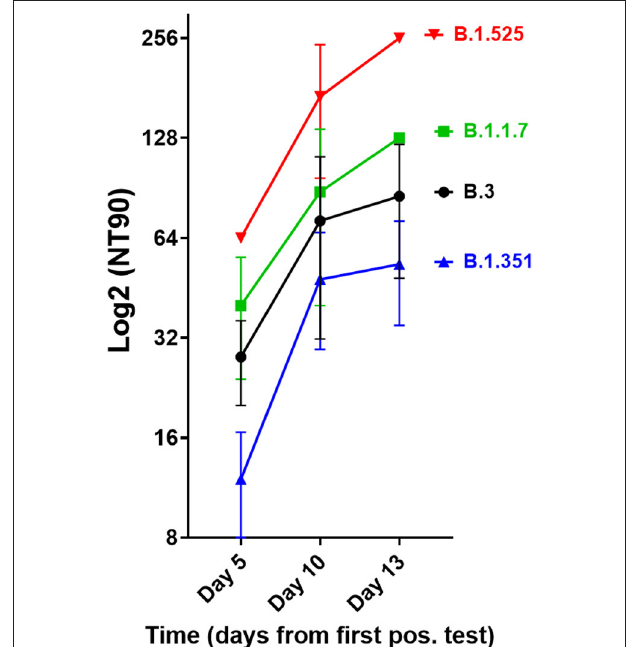
FIGURE 3 | Neutralisation capacity of patient’s plasma on days 5, 10, and 13 after first positive SARS-CoV-2 result. Neutralisation assays were performed with the four virus variants B.3, B.1.1.7, B.1.351, and B.1.525, the latter of which the patient had been infected with. The NT90 value is the corresponding reciprocal of the dilution at which 90% of plaques were suppressed. Results of three independent experiments are shown. Variations in NT values between experiments are indicated by an error